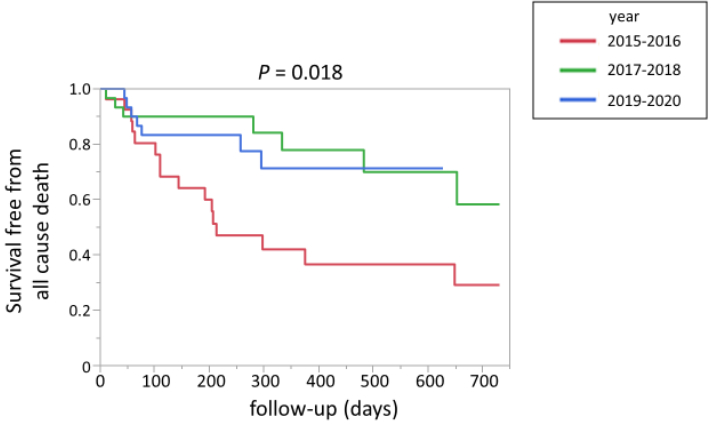
Figure 6. Kaplan–Meier curve for all-cause death in patients with malignancy according to the years of PE diagnosis. PE, pulmonary embolism.